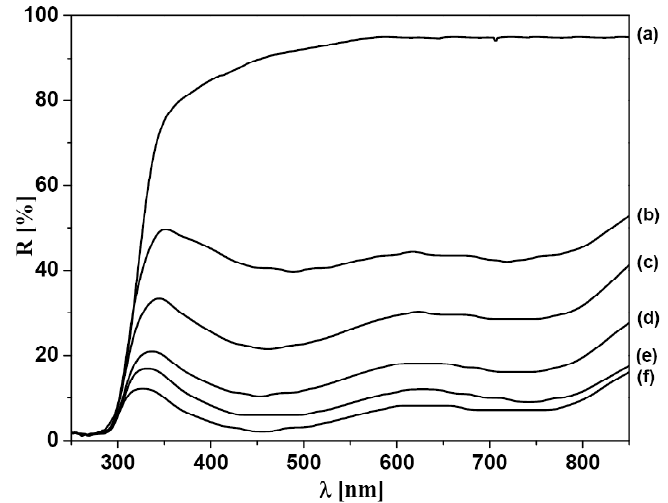
Figure 4. UV-vis spectra of samples: LiNbO